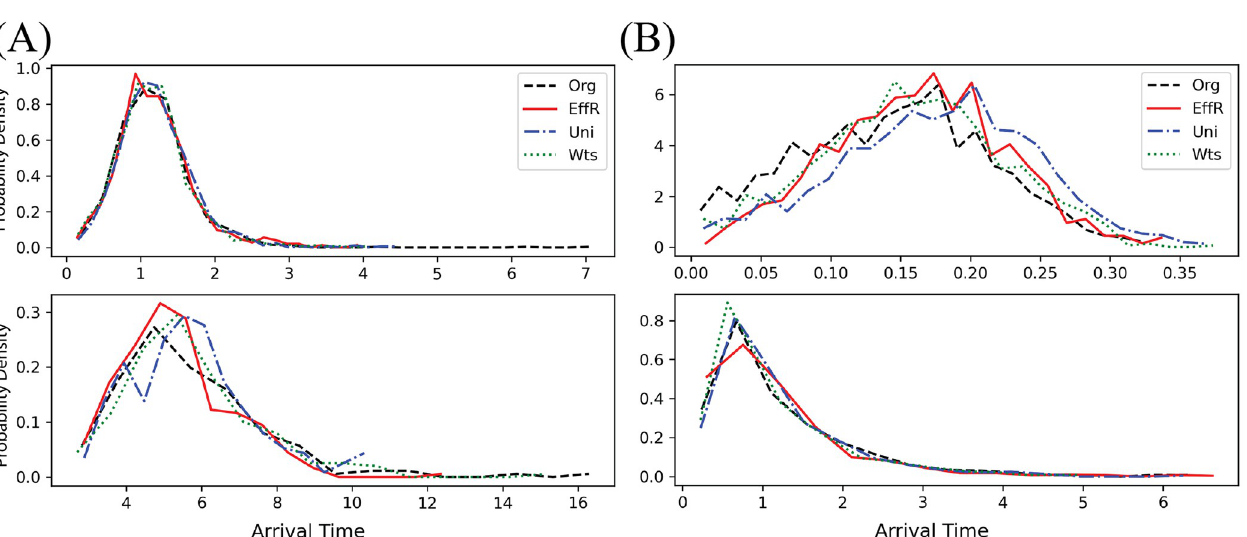
PLOS Computational Biology | https://doi.org/10.1371/journal.pcbi.1010650 November 22,